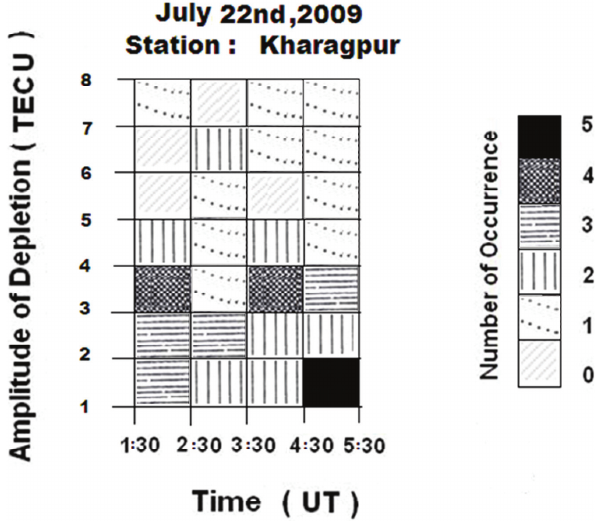
Fig. 7. Amplitude of TEC depletions in excess of 1 TEC unit above an elevation angle of 30 ◦ distributed according to the time of their occurrences and arranged in the form of a block. The different shades on the block indicate number of depletions of particular am- plitude observed during a specific 1h time